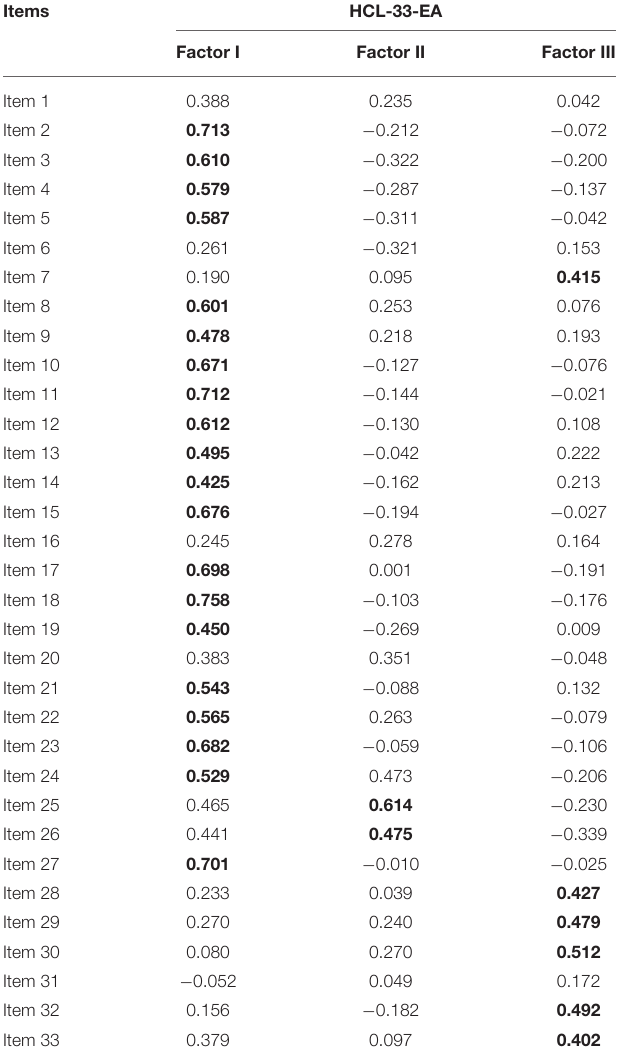
TABLE 3 | Factor loadings of the